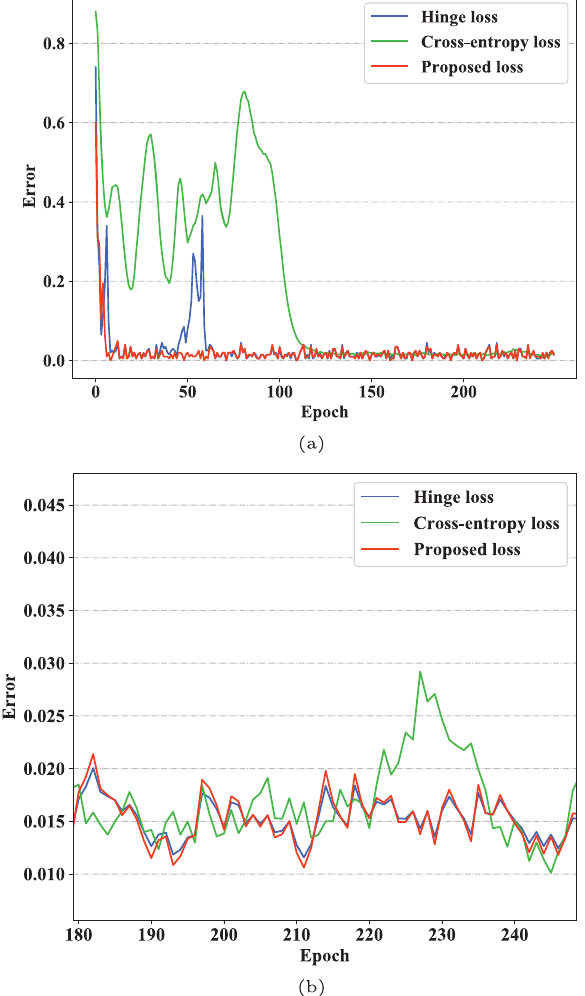
Fig. 5 Smoothed test error on CIFAR-10 for cross-entropy loss, hinge loss, and proposed loss: (a) epochs 0–250, (b) epochs 180–250.